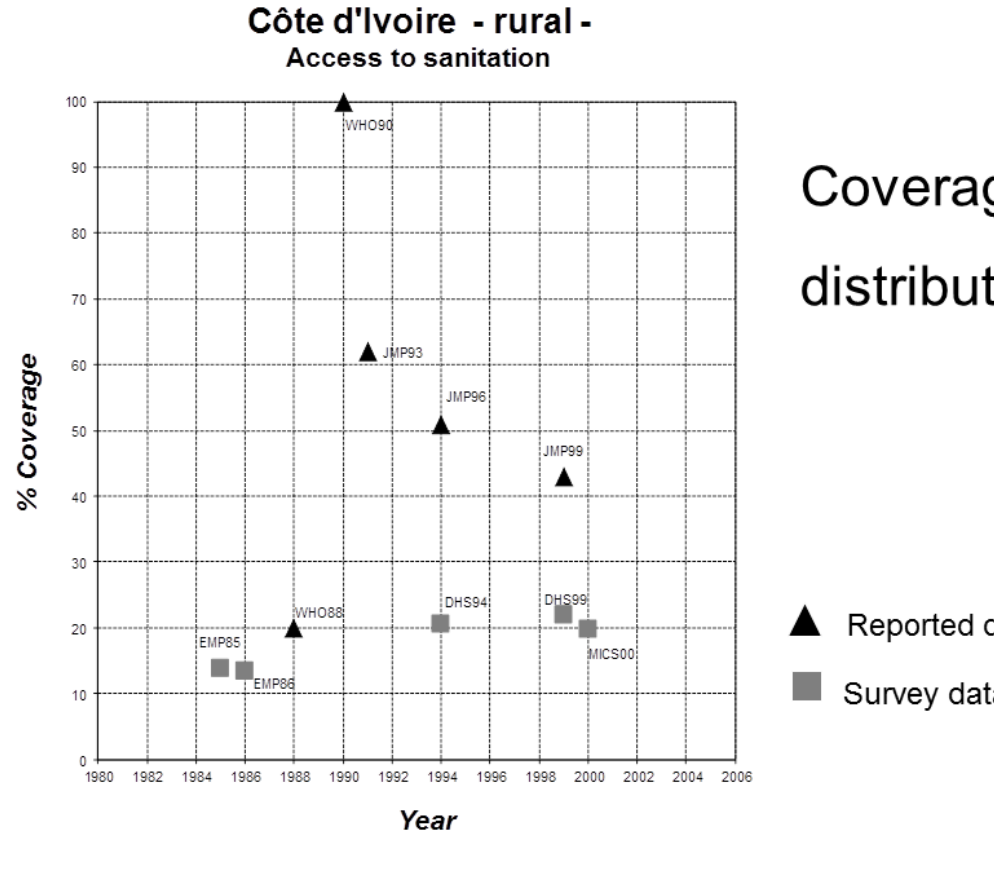
Figure 4. Comparison of line ministry reported rural sanitation coverage rates vs . coverage rates calculated from household surveys for Cote d‘Ivoire